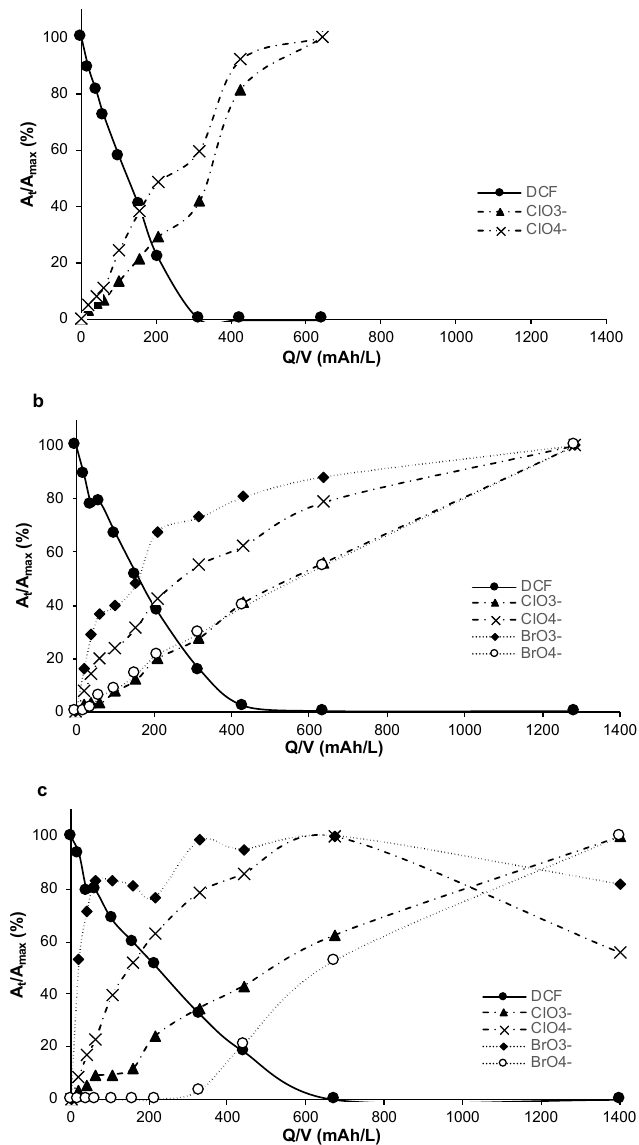
Figure4. Formationofinorganicby-productsduringDCFdegradationasderivedfromRPLC-HILIC-MS Figure 4. Formation of inorganic by ‐ products during DCF degradation as derived from RPLC ‐ HILIC ‐ analysis in deionized water ( a ), drinking water ( b ), and wastewater e ffl uent ( c ) at 292 mAh / cm 2 MS analysis in deionized water ( a ), drinking water ( b ), and wastewater effluent ( c ) at 292 mAh/cm 2 .